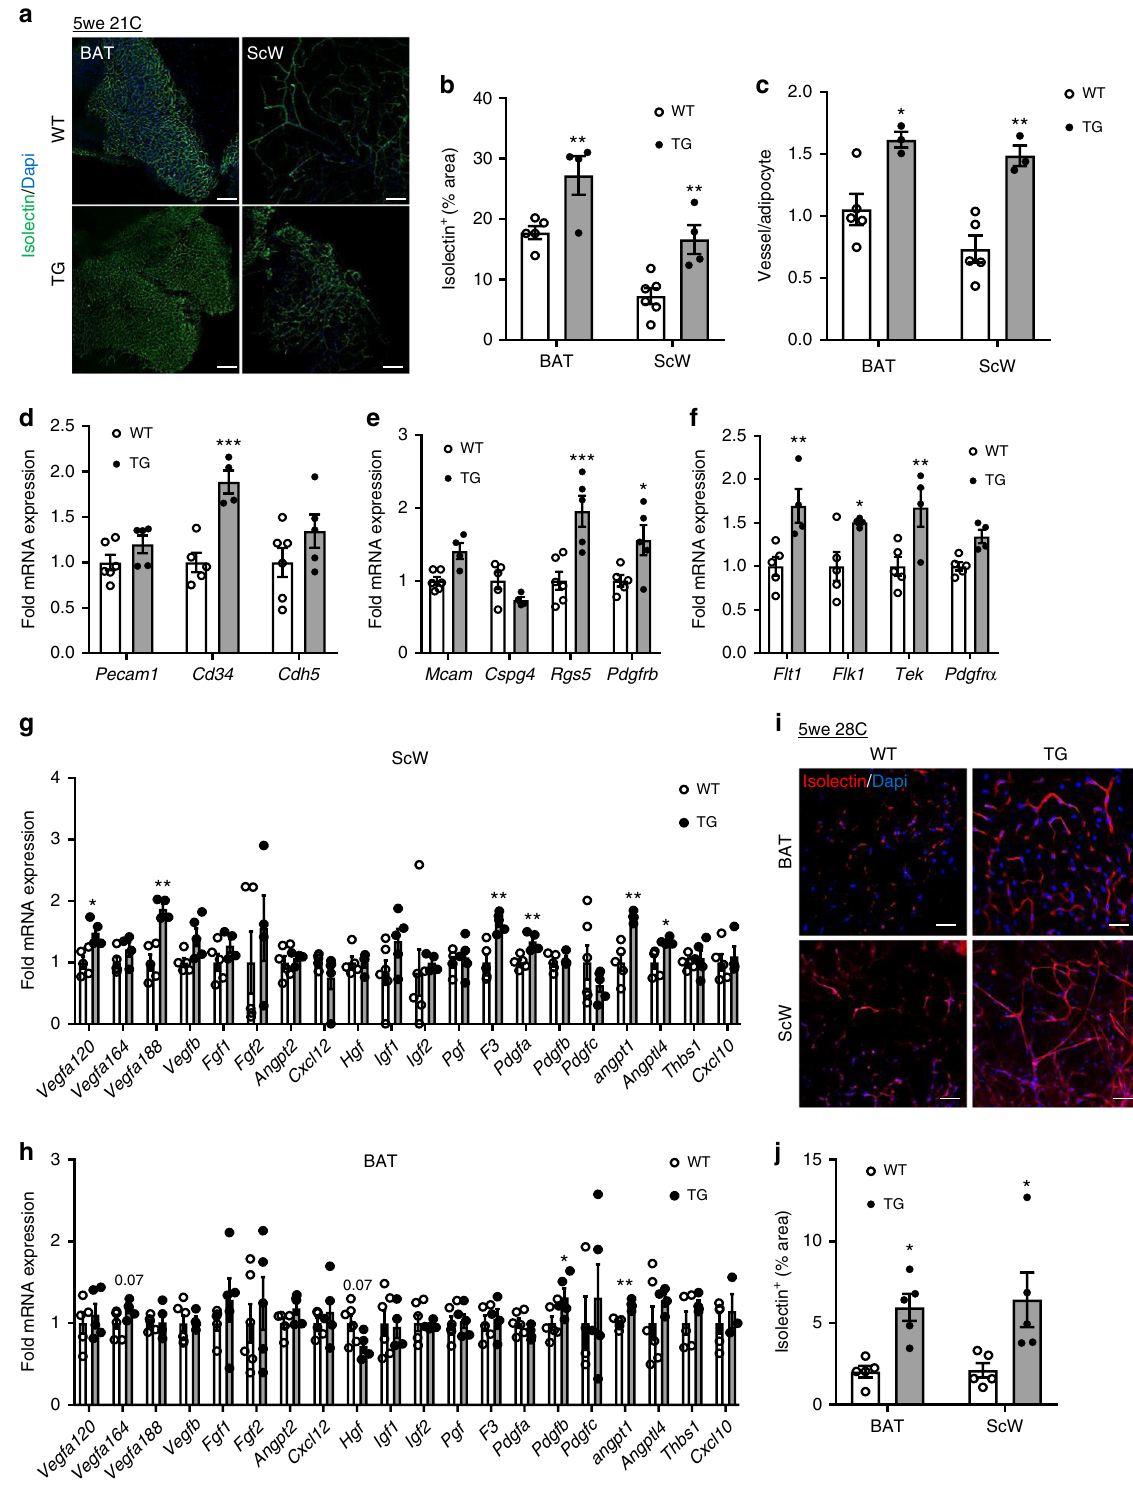
between two close time point, 4-week-old and 5-week-old mice (Supplementary Figure 10). Our results did not show clear temporal differences in the differential regulation of thermogenic, angiogenic and neurogenic factors, which were all mostly up- regulated at 4-week-old in BAT and ScW. These results support the tight co-expression and co-regulation of thermogenic, angiogenic and neurogenic